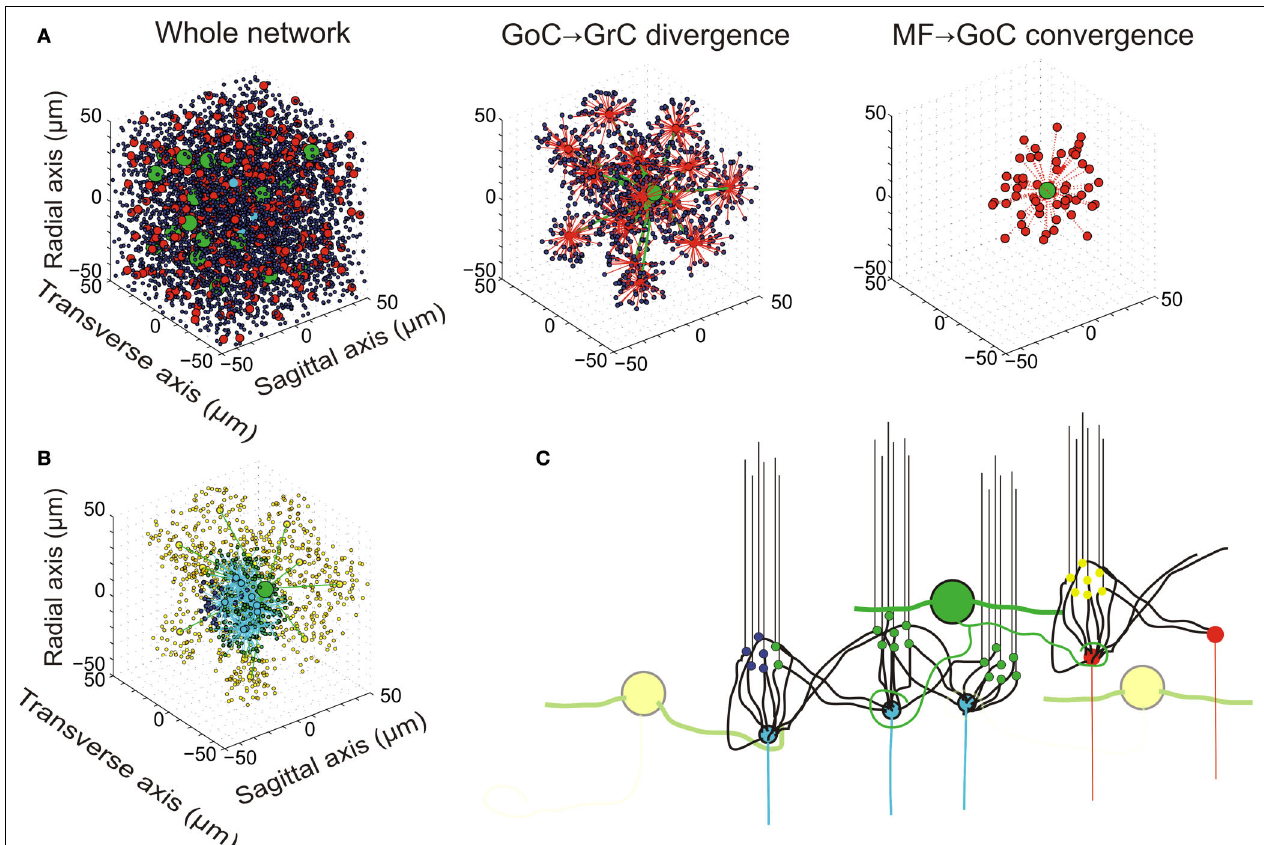
delivered to a small mf bundle. In this example, which is drawn from the network shown in (A) , eight glomeruli represented with cyan dots were supposed to delivered a burst (fi ve spike at 500 Hz) to the network. One of the GoCs excited by the burst [the same as in (ii) ] is indicated with a large green dot. The GrCs are indicated with small dots: GrCs that are only inhibited are yellow, GrCs that are only excited are blue, GrCs that are both excited and inhibited are green. Note that excitation is concentrated in the center and inhibition in the surround. (C) Schematic drawing of network connectivity [same color code as in (B)